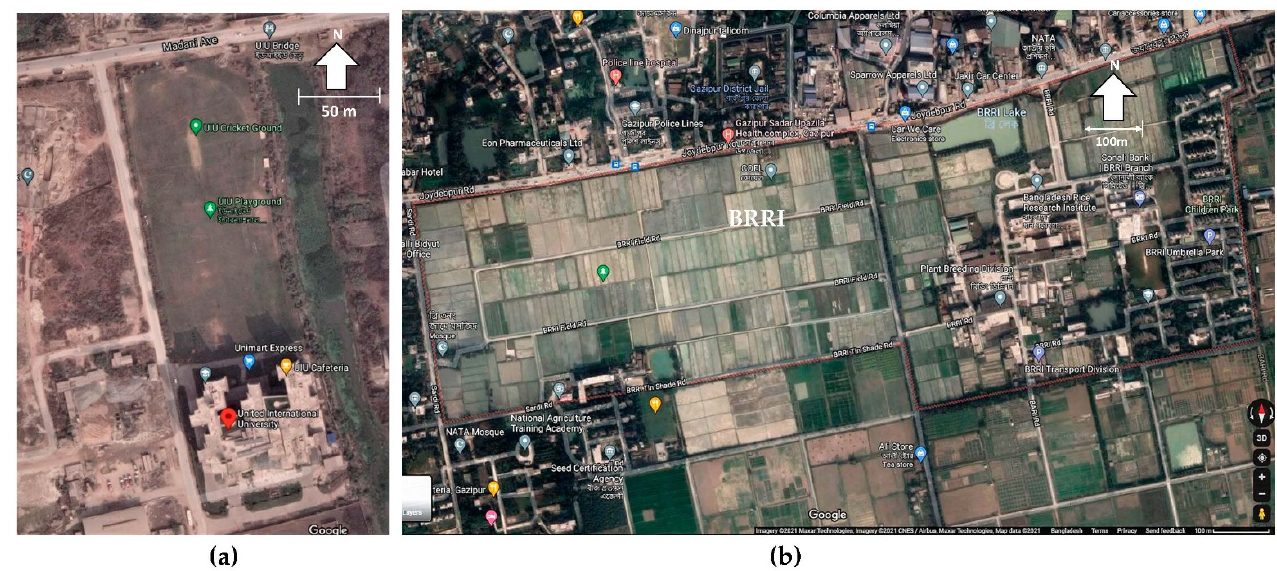
Figure 9. Field trial location: ( a ) On-campus trial at United International University. ( b ) Agricultural land trial at BRRI.